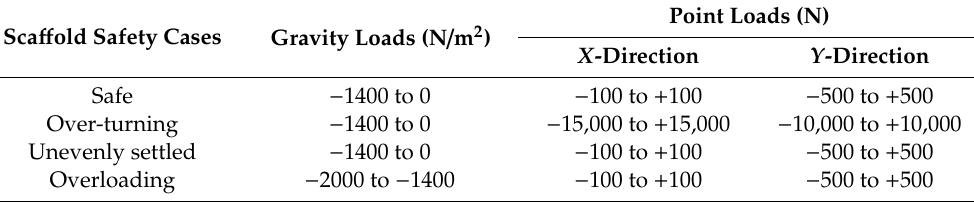
Table 1. Loads applied for structural analysis.